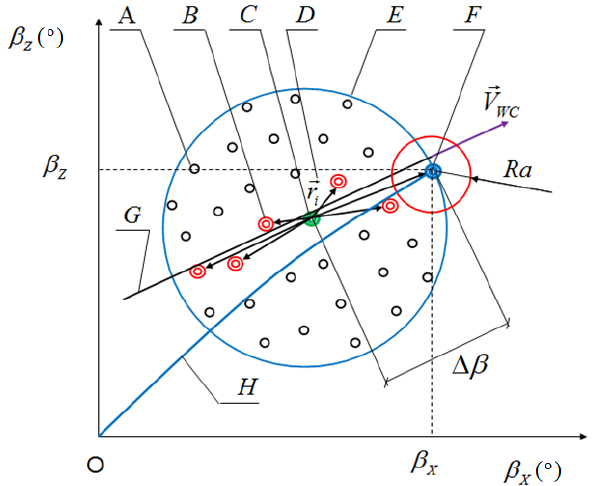
Figure 7. Diagram of filtering signals received by the optoelectronic system of the seeker. O, current position of the seeker axis; A, infrared detector pulses; B, selected maximum pulses; C, currently set angular position for controlling the seeker axis; D, status vectors (one of the Kalman filter criteria); E, selection area (one of the Kalman filter criteria); F, next, set angle position for controlling the seeker axis (result of filtration operation); G, target flight trajectory; H, set trajectory for seeker axis movement; Ra, corrective lens system visual field radius; ∆ β , variable coefficient depending on the speed vector value of the detected V WC